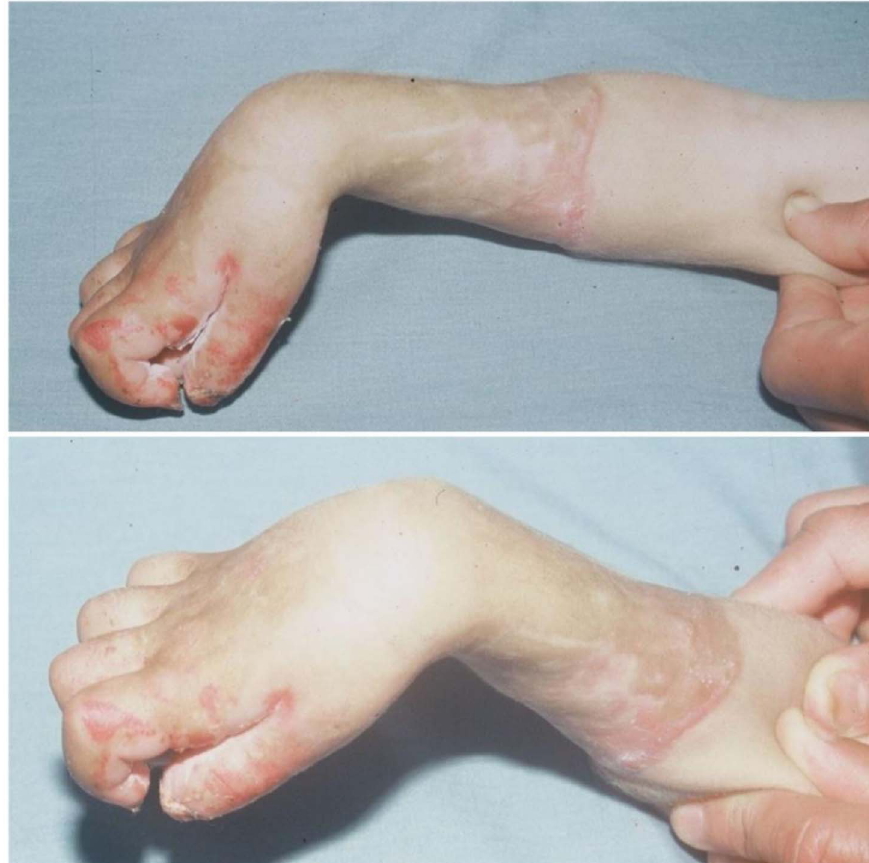
Figure 5. The speci fi c sign, which is the indelible trace of the encircling material.